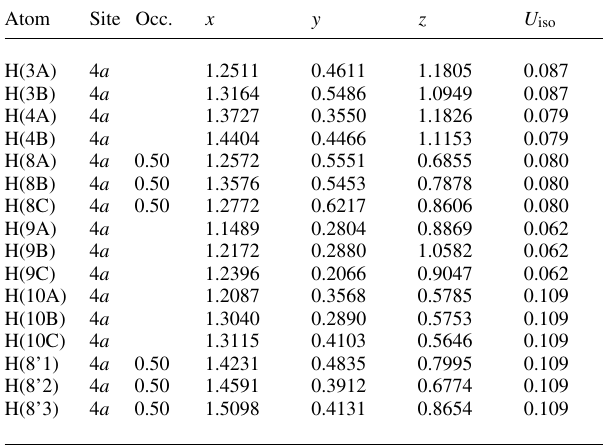
Table 2. Atomic coordinates and displacement parameters (in Å 2 )